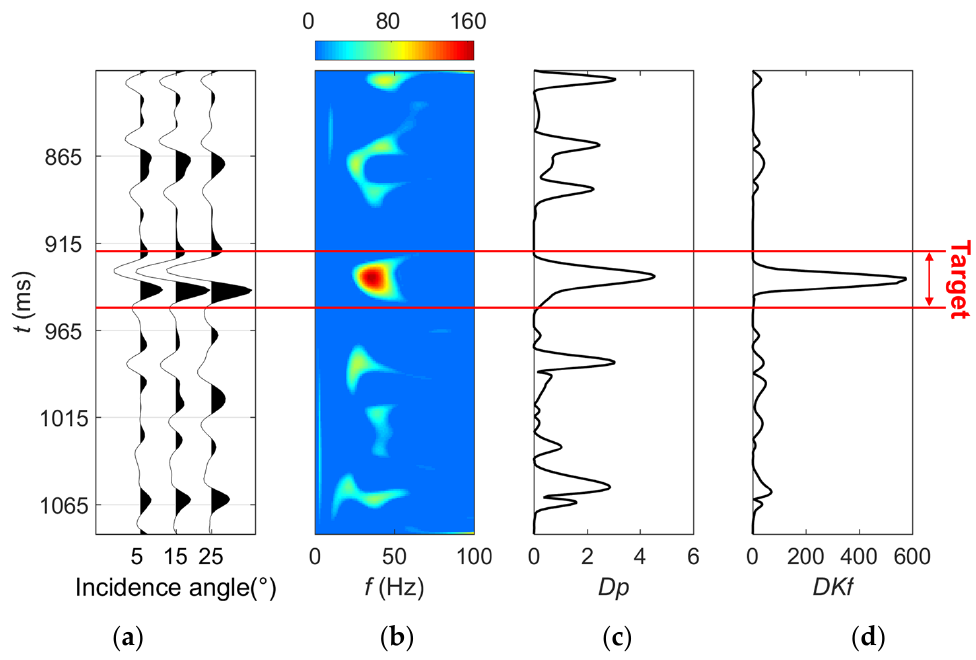
Figure 14. ( a ) Real seismic AVO data across well A, ( b ) spectral decomposition computed using the ISD method for the corresponding stacked trace, and inverted dispersion attributes ( c ) D P , and ( d ) D Kf . The two red lines indicate the target tight sandstone gas reservoir.